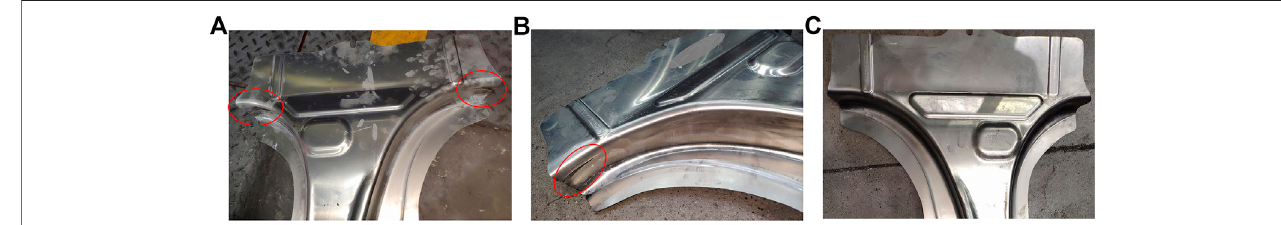
Frontiers in Materials |